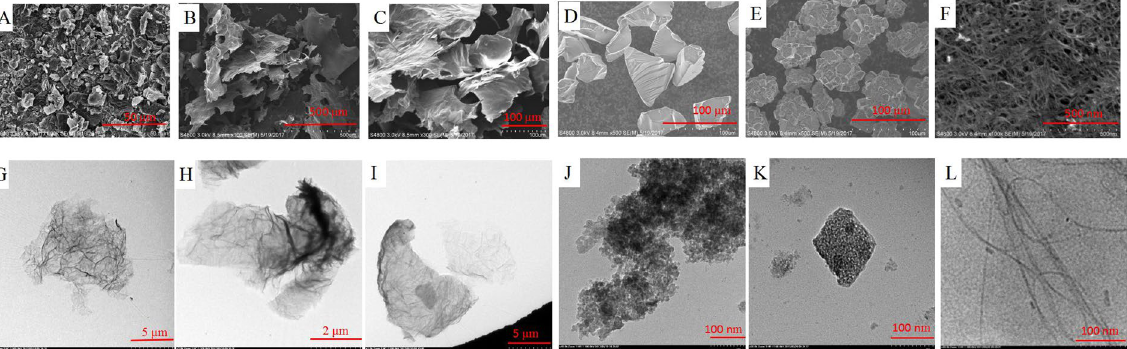
Figure 2. SEM and TEM images of graphene ( A , G ), graphene oxide (powder) ( B , H ), graphene oxide (sheet) ( C , I ), Al 2 O 3 ( D , J ), C18 ( E , K ) and SWNT ( F , L